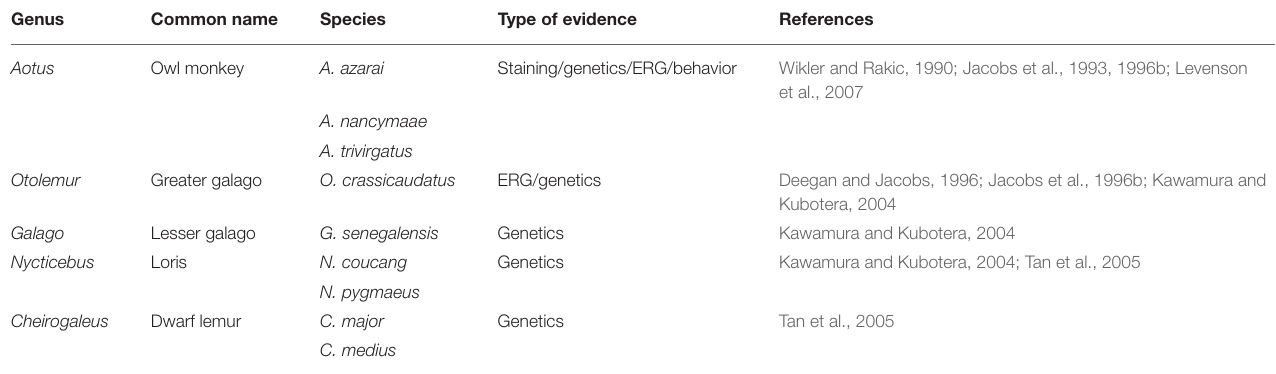
TABLE 2 | Loss of short-wavelength cone function in primates as a result of opsin gene mutations.